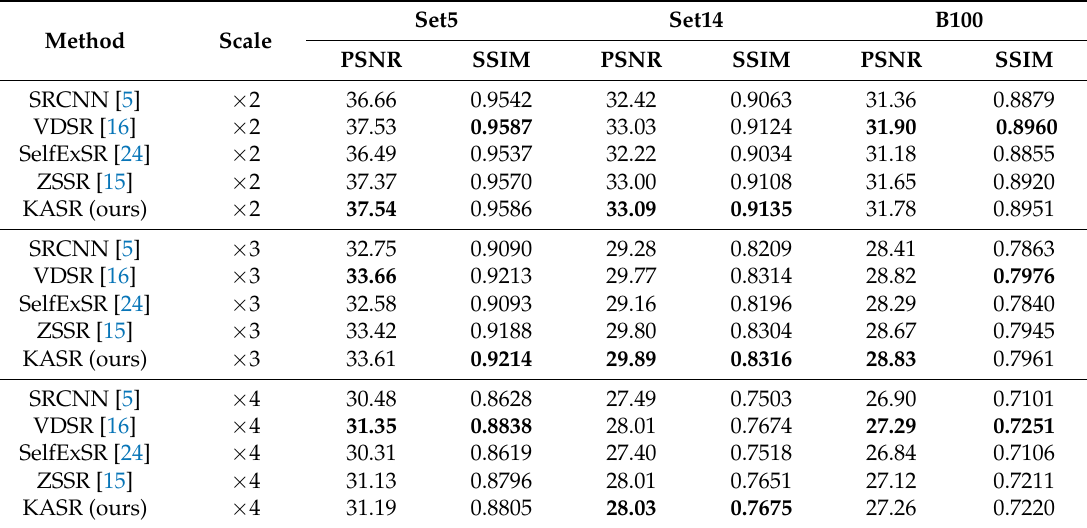
Table 2. Comparison of SR results for Bicubic blur kernel cases.